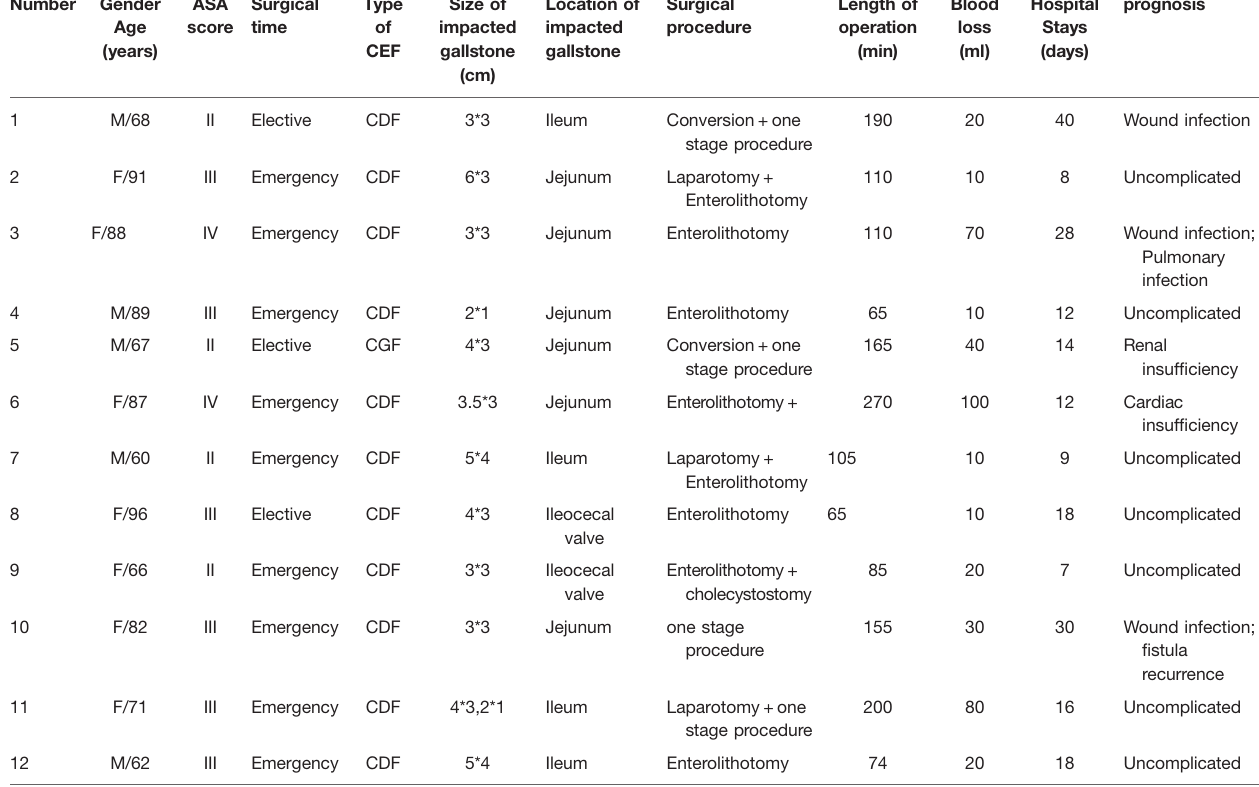
TABLE 4 | Details for all patients diagnosed with CEF combined with GI. Number Gender Age (years)